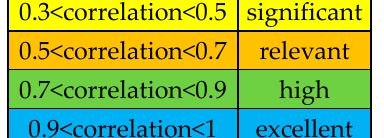
Molecules 2019 , 24 , 2813